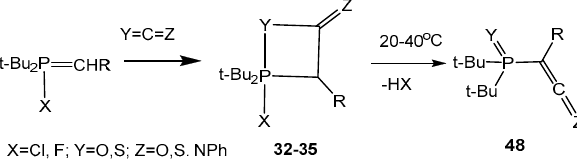
Table 9. Preparation of phosphorylated ketenes, thioketenes, ketenimines 48 (Scheme